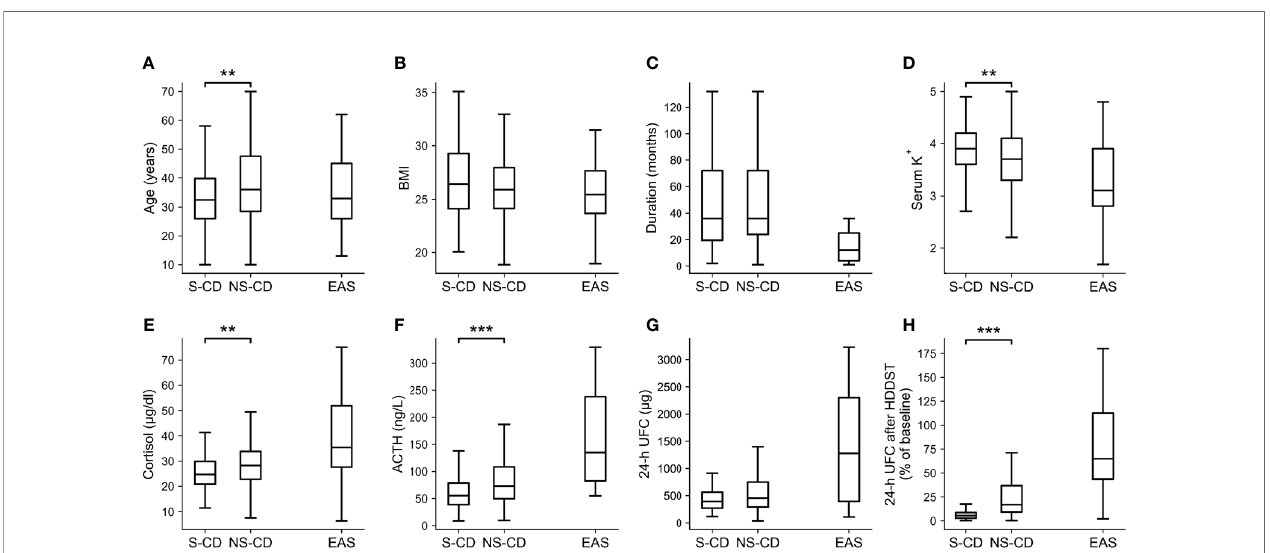
FIGURE 4 | Clinical characteristics of the CD patients whose UFC was suppressed (S-CD) or cannot be suppressed (NS-CD) to <26% of baseline during LDDST and the EAS patients. (A) Age. (B) Body mass index (BMI). (C) Duration of disease. (D) Serum potassium level. (E) Morning cortisol. (F) ACTH. (G) 24-hour urine free cortisol (UFC). (H) 24-h UFC after high-dose dexamethasone suppression test. Box: interquartile range (IQR). Line inside the box: median. Whisker: maximum and minimum within median ± 1.5 × IQR. Outliers outside 1.5 IQR were not shown. Comparisons were only made between S-CD and US-CD but not EAS. *p < 0.05. **p < 0.01. ***p < 0.001.